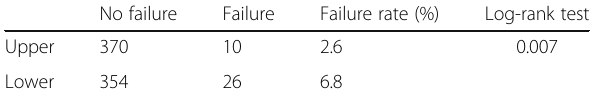
Table 4 Bond failure rates for upper and lower dental